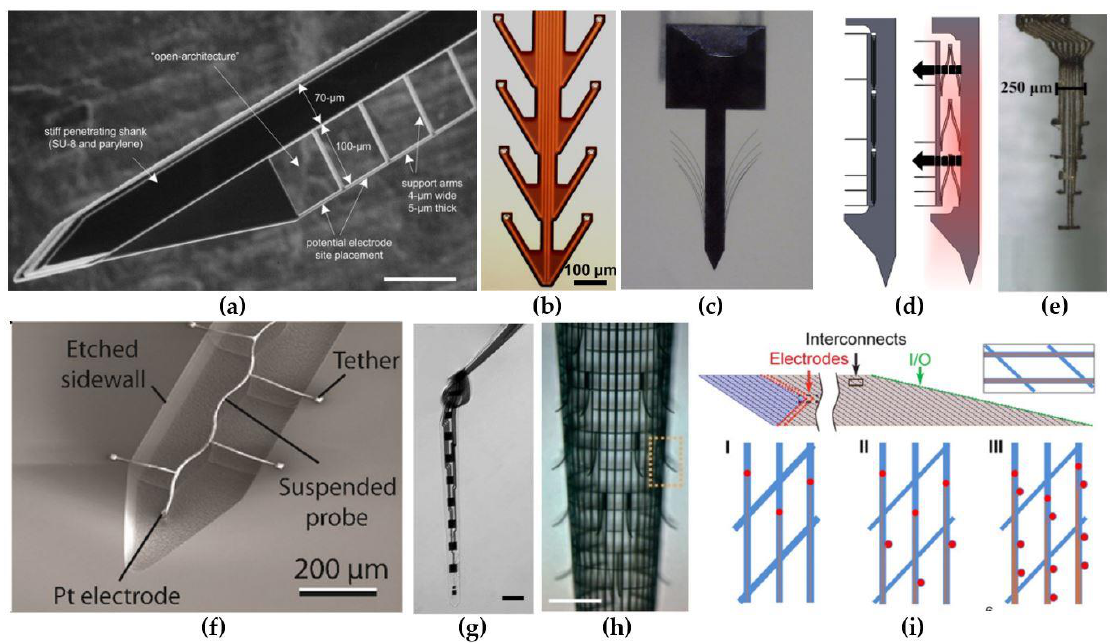
Figure 1. Electrode designs for reduced foreign body reaction (FBR). ( a ) An intracortical probe with a thin, lateral platform, which allows positioning of the recording sites 100 µm away from the main, perturbating probe shank. Scale bar, 100 µm. Reproduced with permission from [42]; published by Elsevier, 2007. ( b ) A fish-bone shaped neural probe. Reproduced with permission from [69]; published by IEEE, 2011. ( c ) Photograph of the splaying probe in agar after slightly retracting. Reproduced with permission from [70]; published by IEEE, 2019. ( d ) Illustration depicting the state of the self-deploying probe before and after the dissolution of the temporary glue. Reproduced with permission from [71]; published by IEEE, 2011. ( e ) A highly-flexible electrode array consisting out of eight encapsulated gold leads. Each lead is able to move independently from the others, since they are not interconnected. Reprinted with permission from [72]; published by Frontiers, 2015. ( f ) Ultra-miniature, meandered probe, with a single Pt electrode at the end. Reproduced with permission from [73]; published by Springer, 2016. ( g ) A NET-50 probe suspended in water, knotted to illustrate the ultra-high flexibility. Scale bar, 50 µm. Reprinted with permission from [74]; published by AAAS, 2017. ( h ) A cylindrical, mesh electrode with outward-bending arms containing the electrical recording sites. Scale bar, 200 µm. Reproduced with permission from [75]; published by Nature, 2015. ( i ) A planar mesh electrode containing 1, 2 and 4 recording sites, respectively, on each longitudinal element. Reprinted with permission from [76]; published by PNAS, 2017.